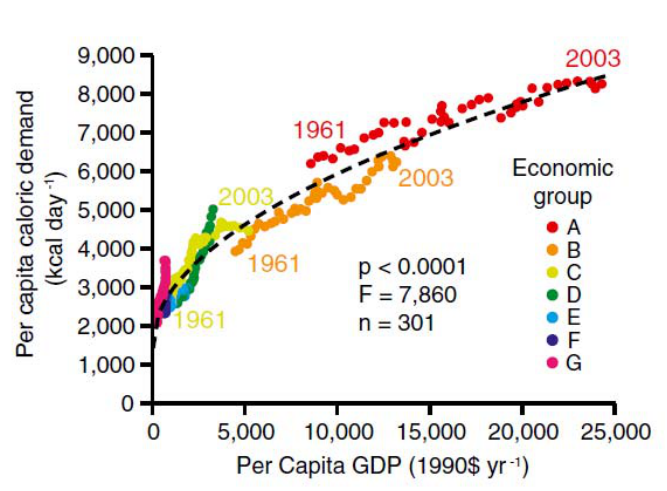
Figure 1. Annual dependence of per capita demand for crop calories on per capita real Gross Domestic Product (GDP) for each of the economic groups A–G